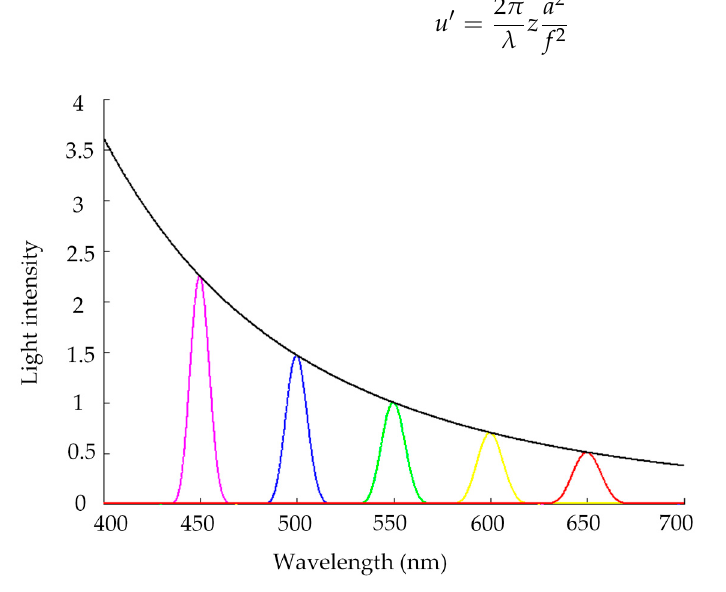
Figure 5. Light intensity distribution with different wavelengths.